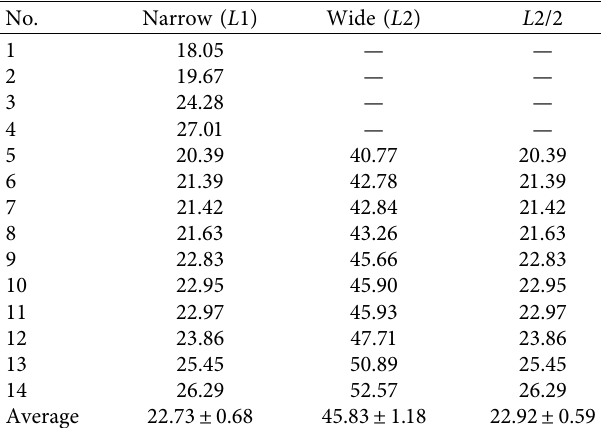
Table 2: Widths (m) of fields at land plot